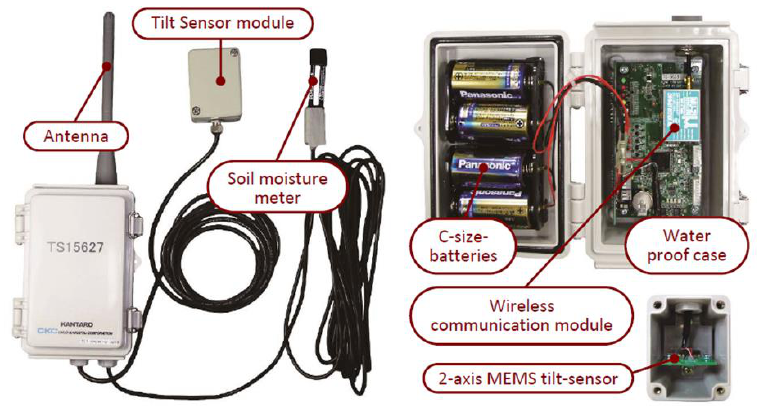
Figure 5. Configuration of a sensor unit.